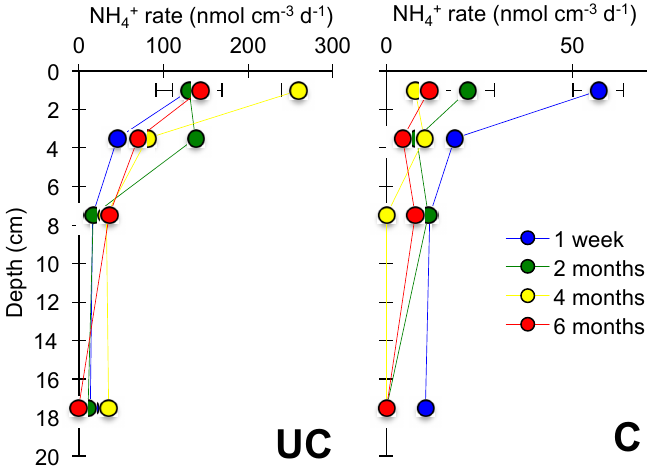
Figure 4. Volume specific ammonium (NH 4+ ) production rates in the uncultivated (UC) and cultivated (C) soils at the four sampling time points. Note the different scales on the x-axes.